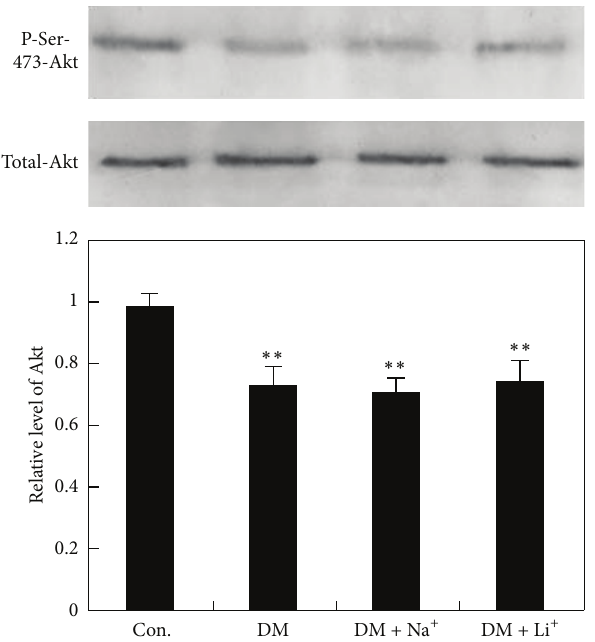
Figure 6: Akt expression. ∗∗ 𝑃 < 0.01 versus control group.